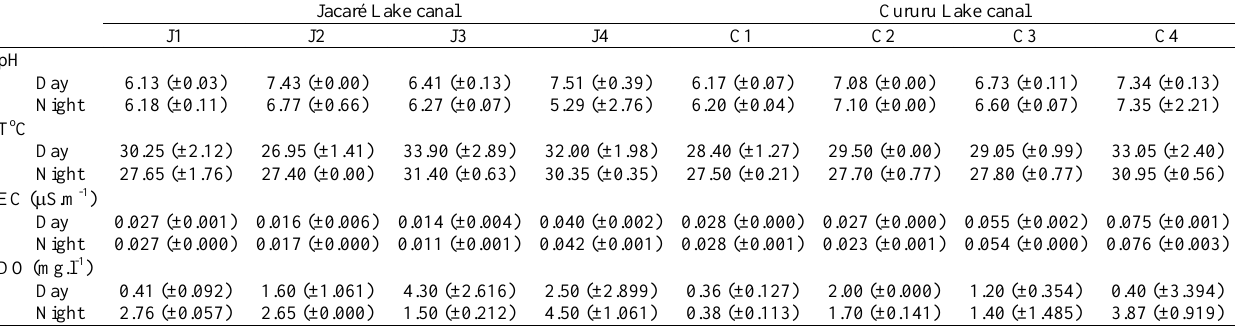
Table 1. Limnological data (averages) for the lake canals studied, including, T o C = temperature in degrees Celsius, EC = electrical conductivity, and DO = dissolved oxygen collected at night (n = 2) and day (n = 2) during the hydrological cycle. Where: J = Jacaré lake canal, C = Cururu lake canal, 1 = Rising water period, 2 = Flood period, 3 = Receding water period, 4 = Drought and ± one standard